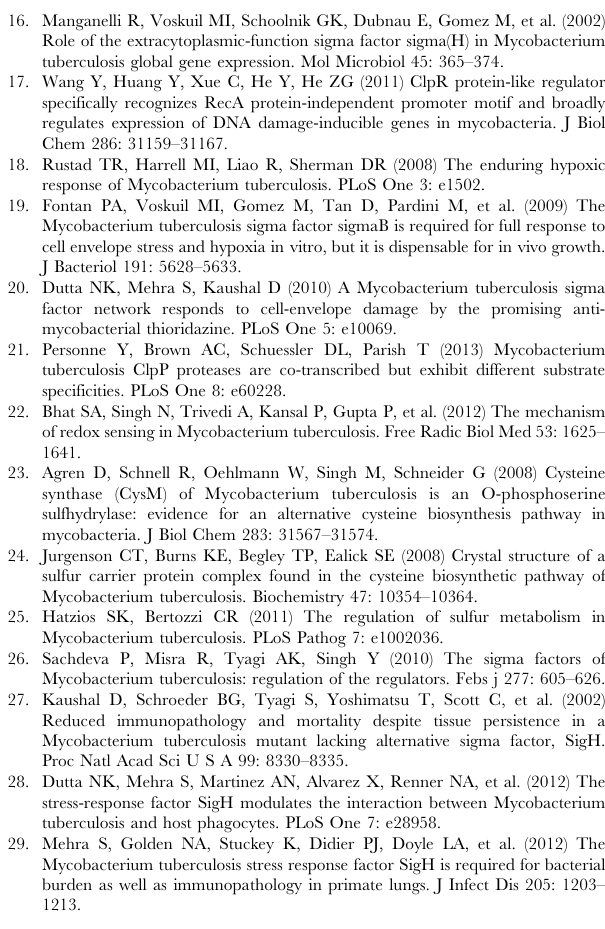
Figure S2 Western Blot of Rv2745c levels. Rv2745c protein levels after 60 minutes post-diamide treatment were detected via Western Blot. Whole cell lysates from several isolated colonies from the complementation were used. Rv2745c levels were restored to similar levels in the complemented strain relative to wild-type. From left to right, lane order: Mtb , Mtb : D Rv2745c (comp, 2), Mtb : D Rv2745c (comp, 4), Mtb : D Rv2745c (comp, 10), Mtb : D Rv2745c. Rv2745c levels were absent in the isogenic mutant 60-minutes post-diamide treatment. Table S1 Primers for PCR, Southern Blot, and